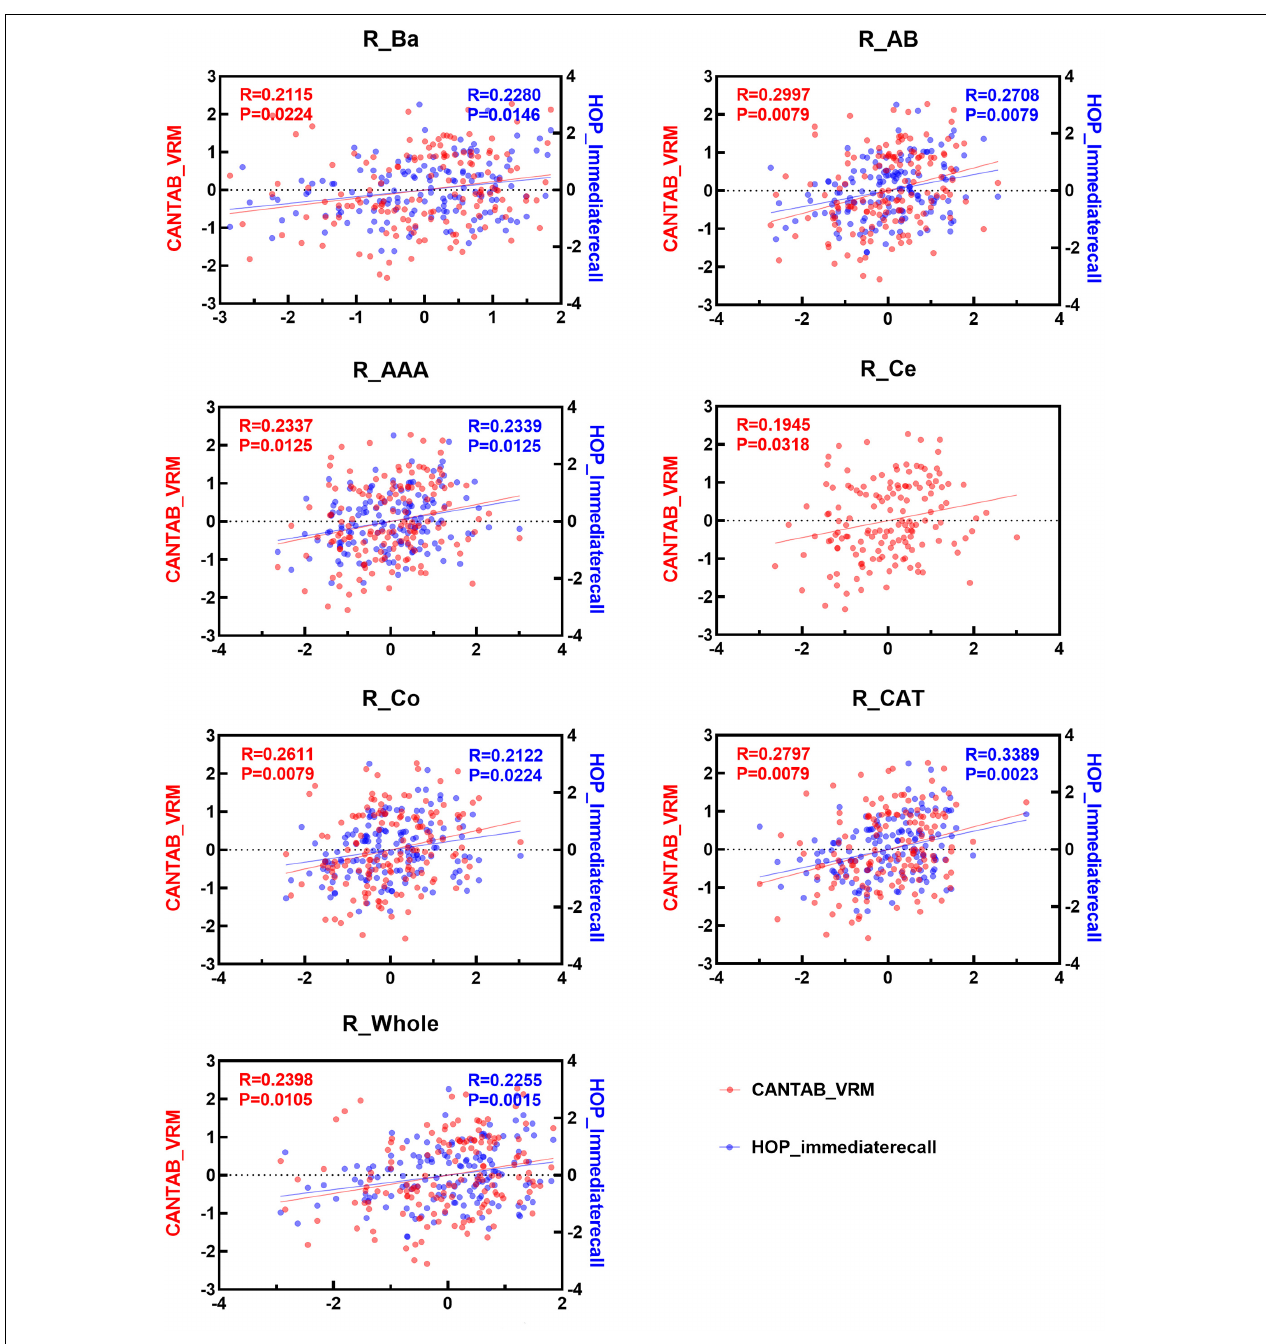
FIGURE 5 | Scatter plots of the Spearman partial correlation between amygdala nuclei volumes and CANTAB_VRM, HOP_immediaterecall scores in the right hemisphere. Only results with significance ( P < 0.05) were presented. R, correlation coefficient; P, p -value of the partial correlation analysis; La, lateral nucleus; Ba, basal nucleus; AB, accessory basal nucleus; Ce, central nucleus; Me, medial nucleus; Co, cortical nucleus; AAA, anterior amygdaloid area; CAT, cortico-amygdaloid transition area; PL, paralaminar nucleus; Whole, whole amygdala; CANTAB_VRM, Cambridge Neuropsychological Test Automatic Battery Verbal Recognition Memory; HOP_immediaterecall, Hopkins immediate